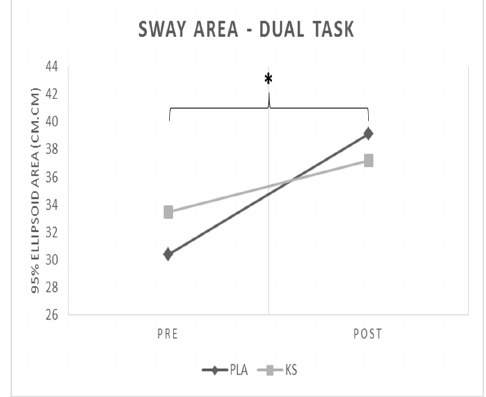
Figure 3. Mean center of pressure sway area during eyes open dual-task postural stability test, before (PRE) and after (POST) the treadmill workload in firefighters. Groups: Placebo (PLA) and Ketone (KS). * represents significant difference between PRE and POST at p < 0.05.